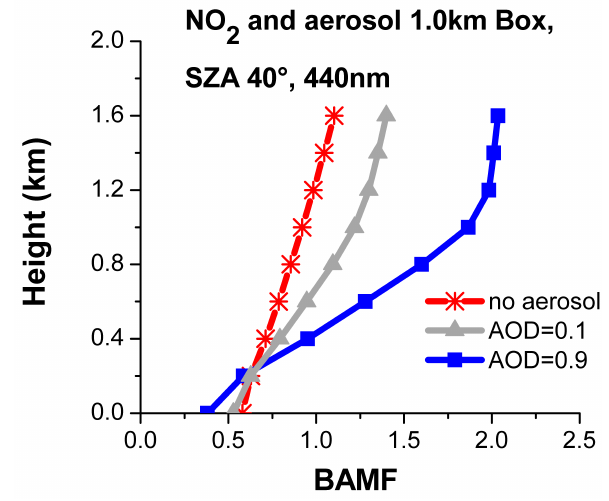
Fig. 1. NO 2 block airmass factor (BAMF) for 3 scenarios: no aerosol (red), and an aerosol layer with SSA of 0.93 extending from the surface to 1.0km with an optical depth (AOD) of 0.1 (grey) and 0.9 (blue). AMFs determined at 440nm, with surface albedo = 0.03, ω 0 = 0.93 and solar zenith angle (SZA) 40 ◦